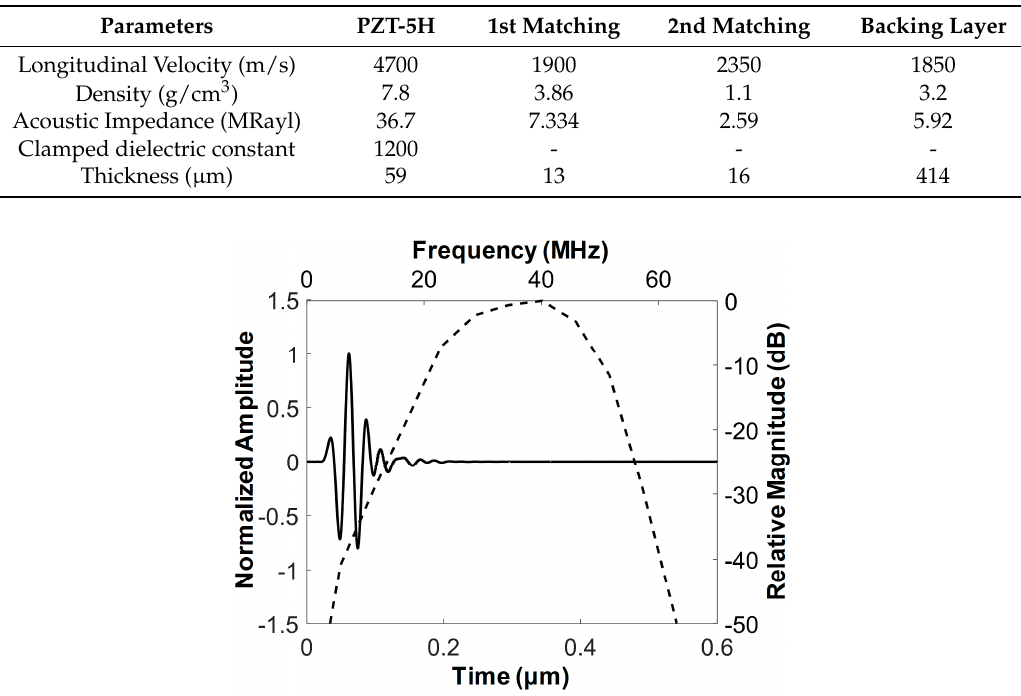
Table 1. Material properties and thicknesses of the piezoelectric material, the acoustic matching layers, and the backing block used for the proposed forward-looking intravascular ultrasound (FL-IUVS) transducer.